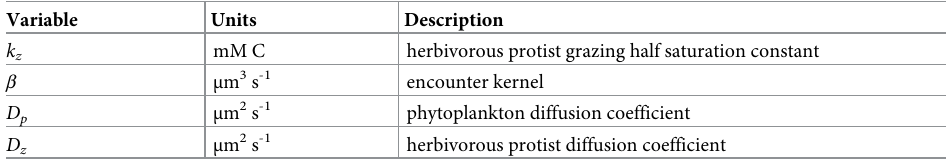
Table 3. Variables based on a compilation of size-dependent relationships. Variables that are a function of several size-dependent relationships, as described in the main